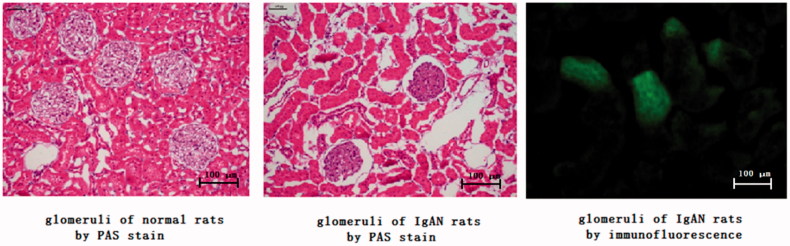
PAS stain and immunofluorescence photograph of IgAN rats model.